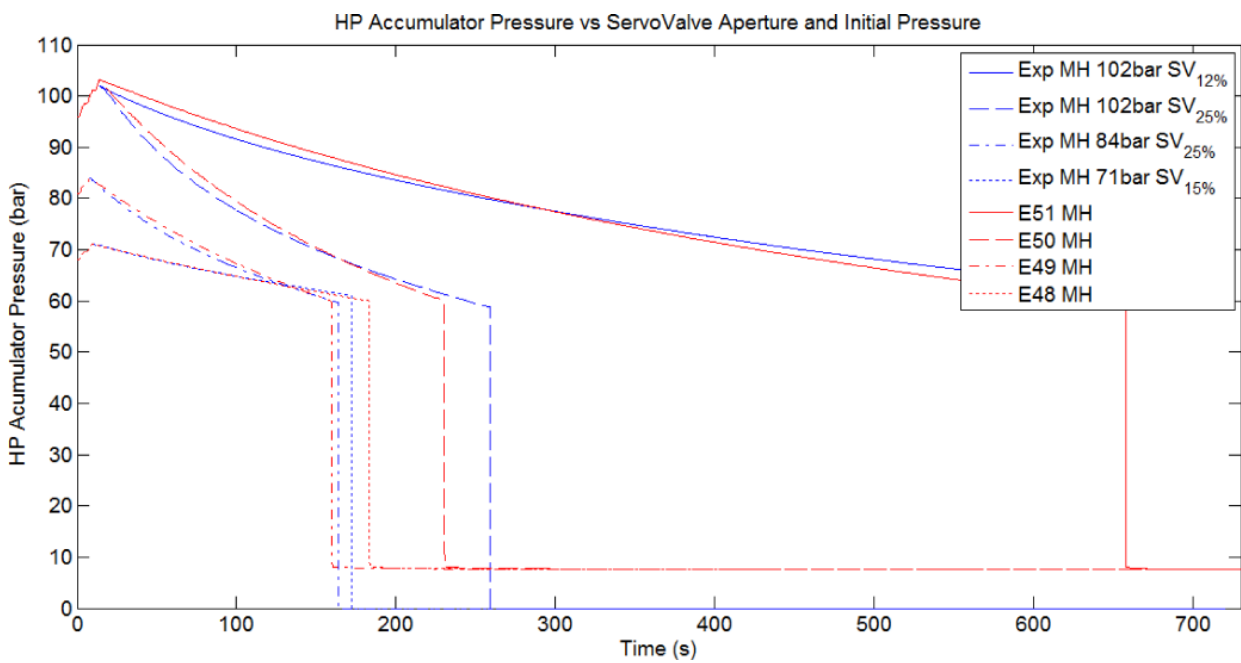
Figure 29. PTO Output. HP Accumulator pressure (bar) comparison between simulated (red) and experimental (blue)